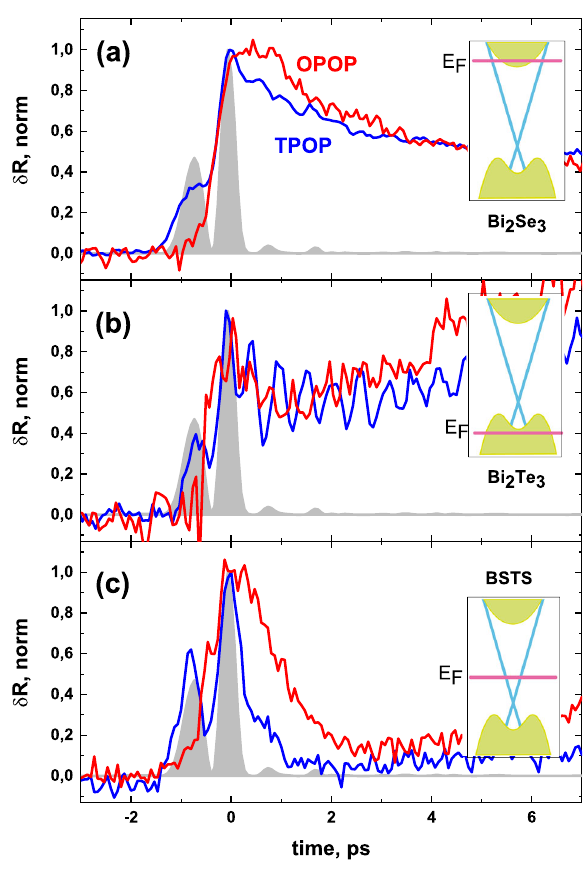
Fig. 1 Transient re fl ectivity spectroscopy. THz-pump optical-probe (TPOP) re fl ectivity measurements in Bi 2 Se 3 ( a ), Bi 2 Te 3 ( b ) and BSTS ( c ) (blue line). The intensity transient of the driving THz fi eld is shown in all panels (gray shaded line). The red line corresponds to the dynamics when using optical excitation with 1.5 eV photon energy (OPOP). The band diagram with the Fermi level of each sample, obtained from THz transmission experiments, is schematically shown in the